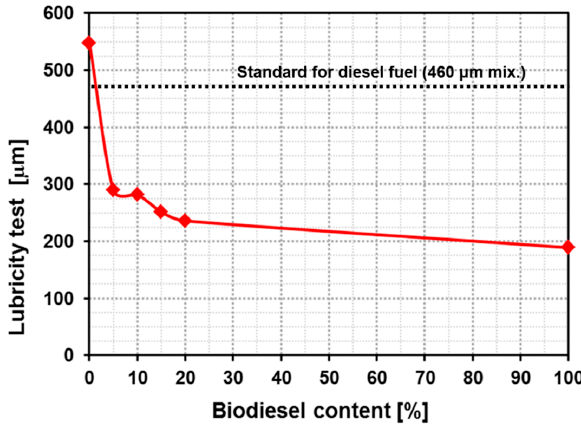
Figure 5. Effect of biodiesel concentration on gasoline- biodiesel lubricity.